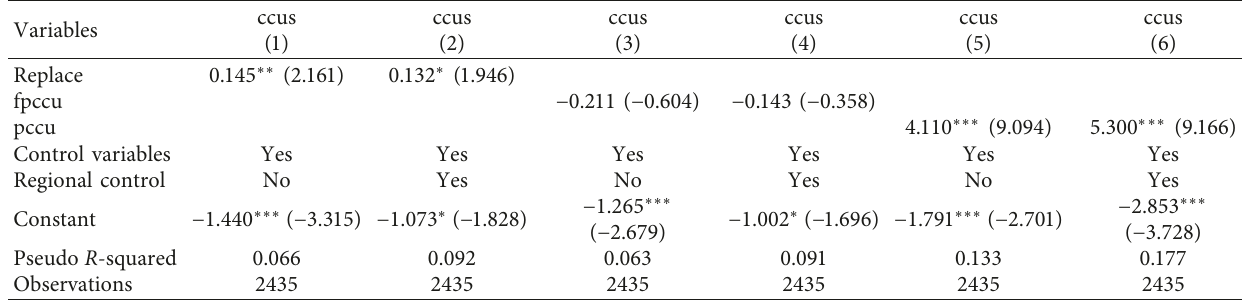
Table 5: Robustness testing.